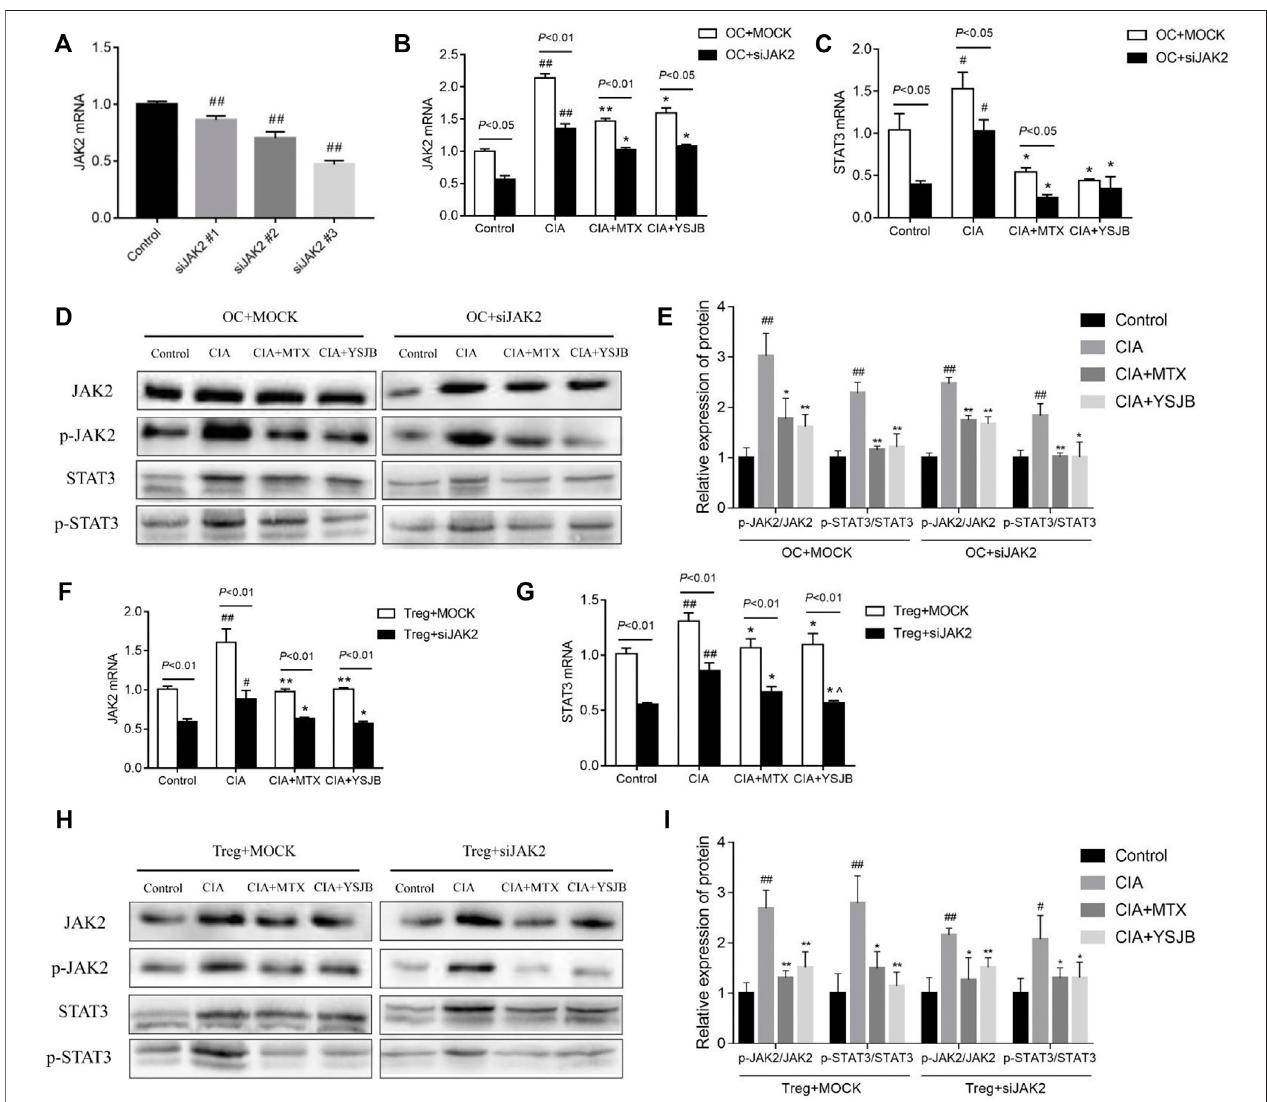
FIGURE 2 | Effect of YSJB and JAK2 siRNA on the JAK2/STAT3 signaling pathway. (A) Con fi rmation of JAK2 knockdown in OCs. (B) The relative mRNA levels of JAK2inOCs. (C) TherelativemRNAlevelsofSTAT3inOCs. (D) RepresentativebandsofJAK2,p-JAK2,STAT3,andp-STAT3proteindetectedbywesternblotassayin OCs. (E) Proteinexpressionlevelsofp-JAK2/JAK2andp-STAT3/STAT3inOCs. (F) TherelativemRNAlevelsofJAK2inTregs. (G) TherelativemRNAlevelsofSTAT3in Tregs. (H) Representative bands of JAK2, p-JAK2, STAT3, and p-STAT3 protein detected by western blot assay in Tregs. (I) Protein expression levels of p-JAK2/ JAK2andp-STAT3/STAT3 inTregs. Cellsweretreatedwithdrug-containingserum andJAK2siRNA. # p < 0.05, ## p < 0.01comparedwiththecontrolgroup; * p < 0.05, ** p < 0.01 compared with the CIA